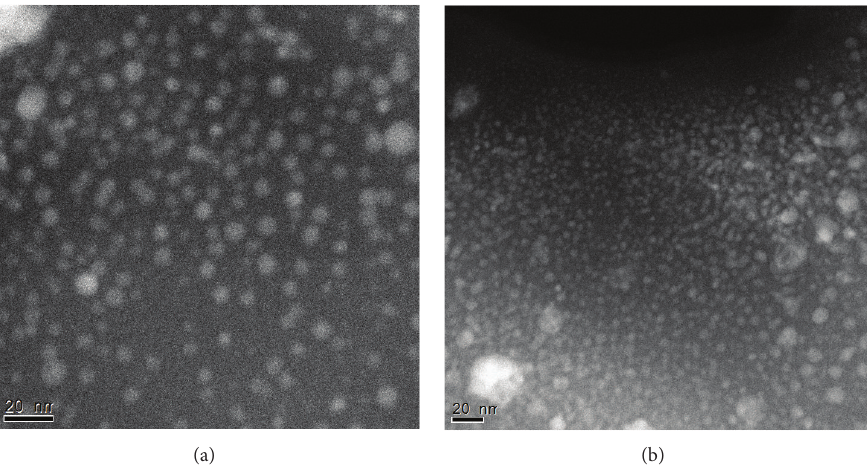
Figure 1: Plan-view TEM micrograph, obtained by using Z contrast technique (HAADF), showing Si-NCs formed inside a silica matrix (SiO 2 ) after being annealed at 1100 ∘ C in RA a piece of SiO 2 with Si ions implantation (1.5 MeV at a fluence of 2.5 × 10 17 ions/cm 2 ).